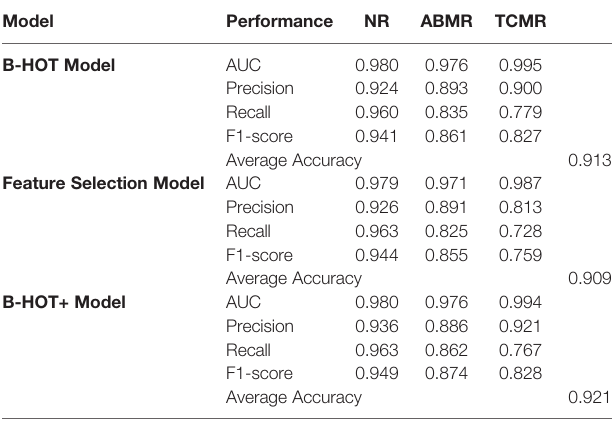
TABLE 3 | Overview of nested cross-validation performances of all